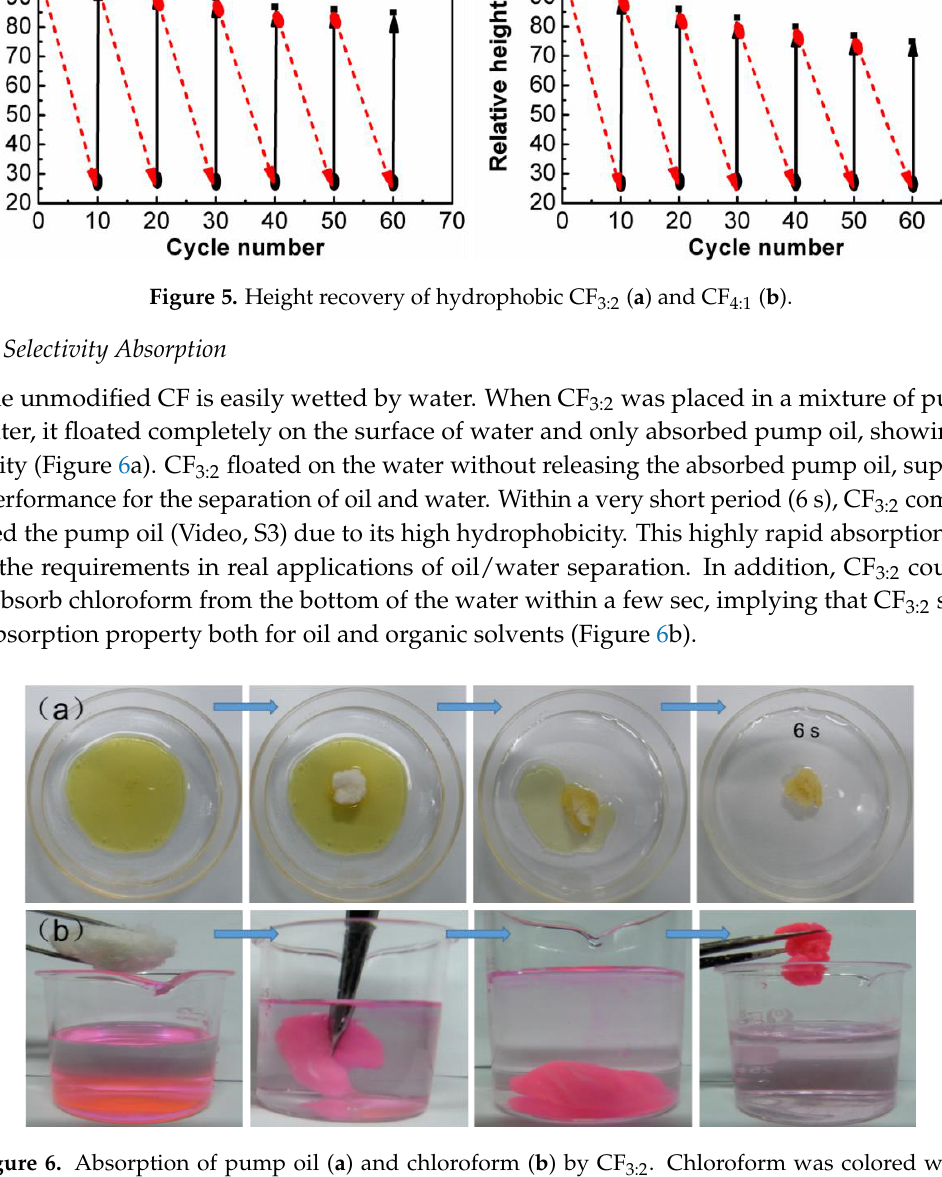
Figure 4. Optical images of water and oil droplets on unmodified and modified CF ( a ), soaking in water ( b ) and water contact angle ( c ). Droplets of water (blue) and silicone oil (red) were colored with bromophenol blue and Sultan three, respectively.